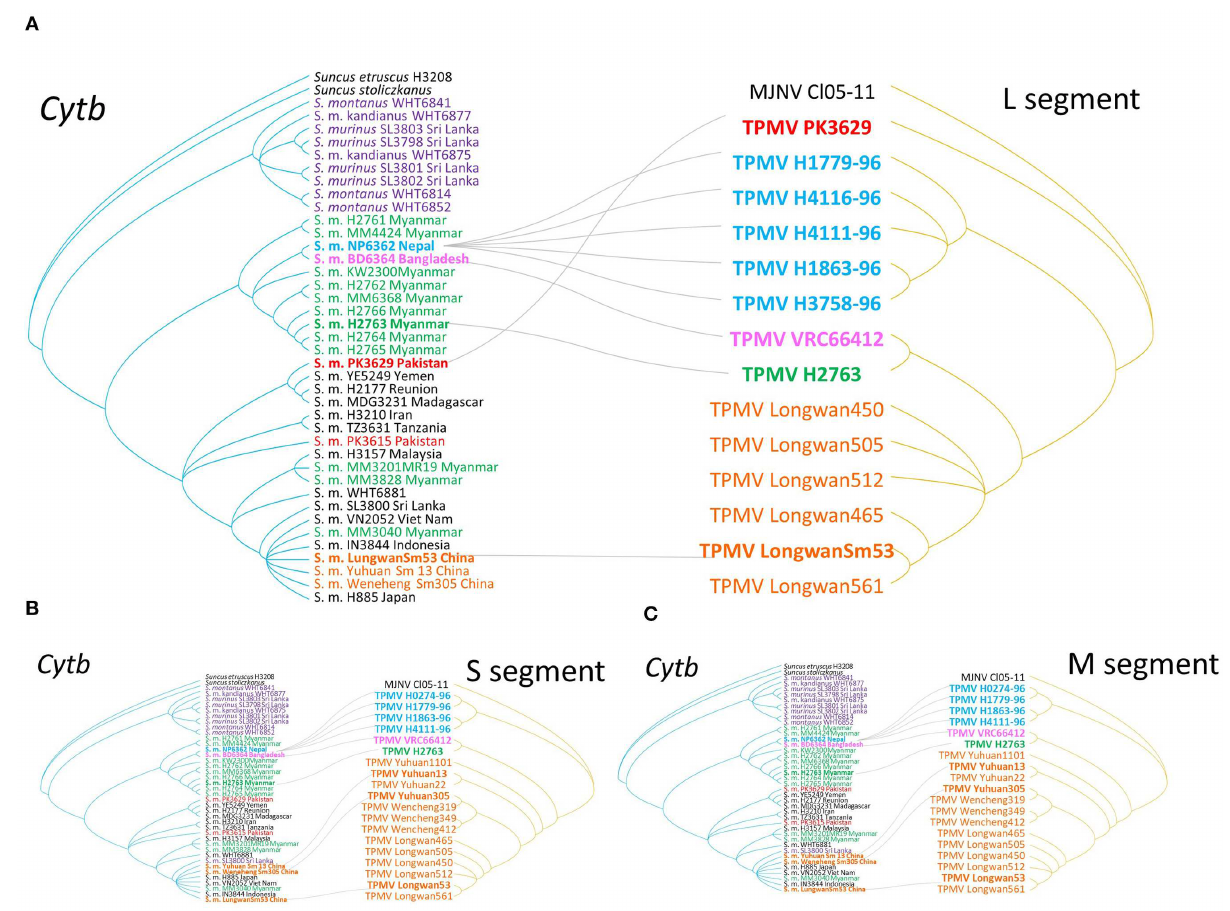
Frontiers in Cellular and Infection Microbiology |